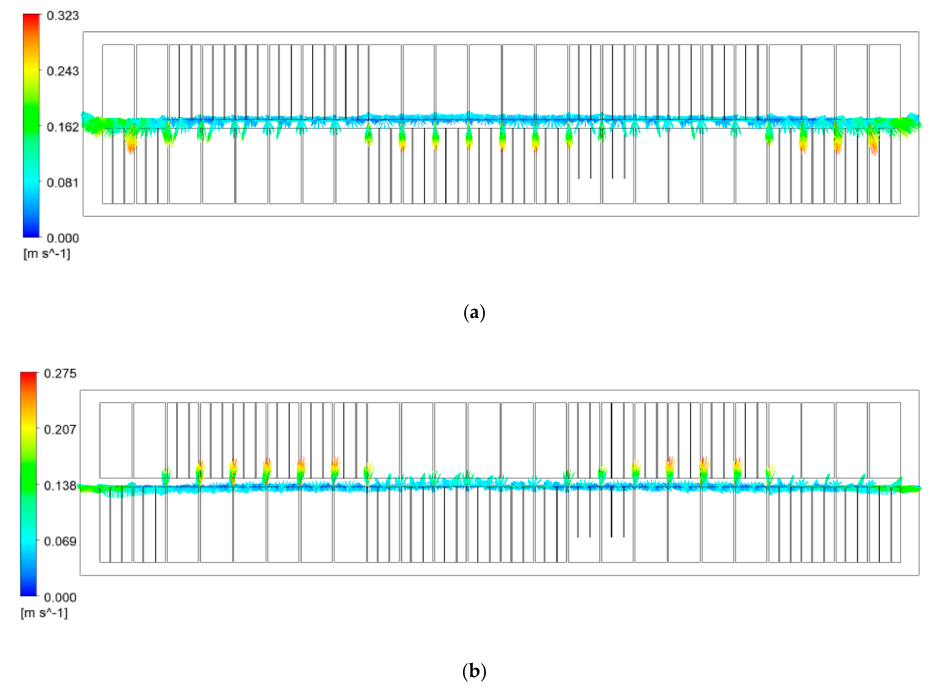
Figure 9. Bath flow in vertical planes in the slotted case 1: ( a ) Y = +70 mm and ( b ) Y = − 70 mm plane.